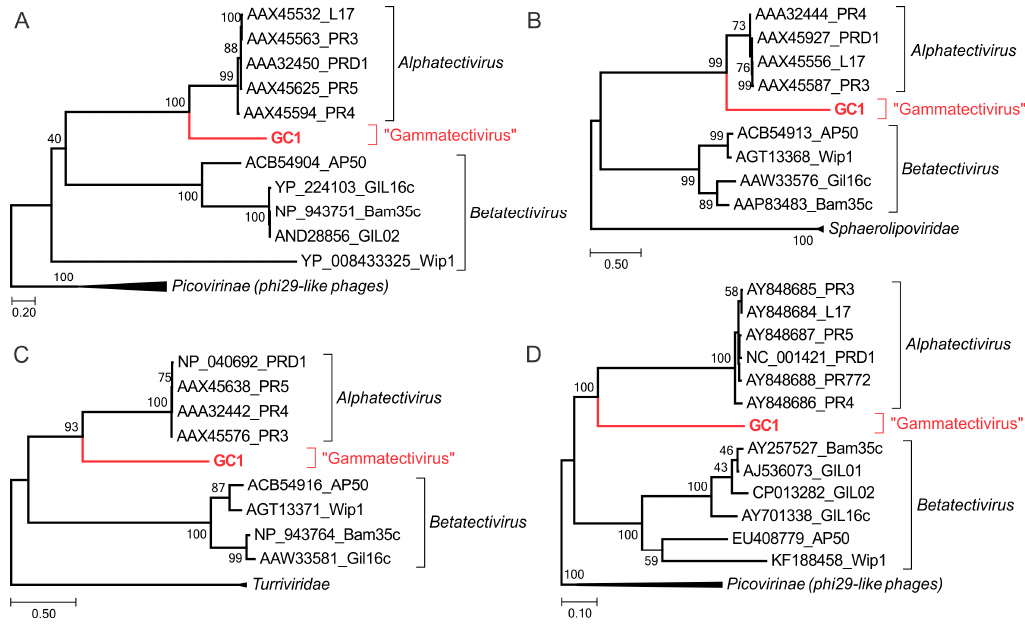
Figure 6. Phylogenetic relationship of GC1 compared with other tectiviruses based on the three conserved proteins: the major capsid protein ( A ); packaging ATPase ( B ) and DNAP ( C ); Phylogenetic tree computed using the Genome BLAST Distance Phylogeny (GBDP) strategy ( D ); Maximum likelihood phylogenetic trees ( A – C ) were computed using the best-fit substitution models for given alignments (see Materials and Methods), as determined by PhyML [50]. The trees were rooted with taxa including the closest homologs of the corresponding proteins outside of the family Tectiviridae . Scale bars in ( A – C ) represent the number of substitutions per site, whereas in panel ( D ); the branch lengths are scaled according to the distance formula ( d 6 ) used for the calculation, i.e. sum of all identities found in high-scoring segment pairs between the two proteomes divided by total genome length.